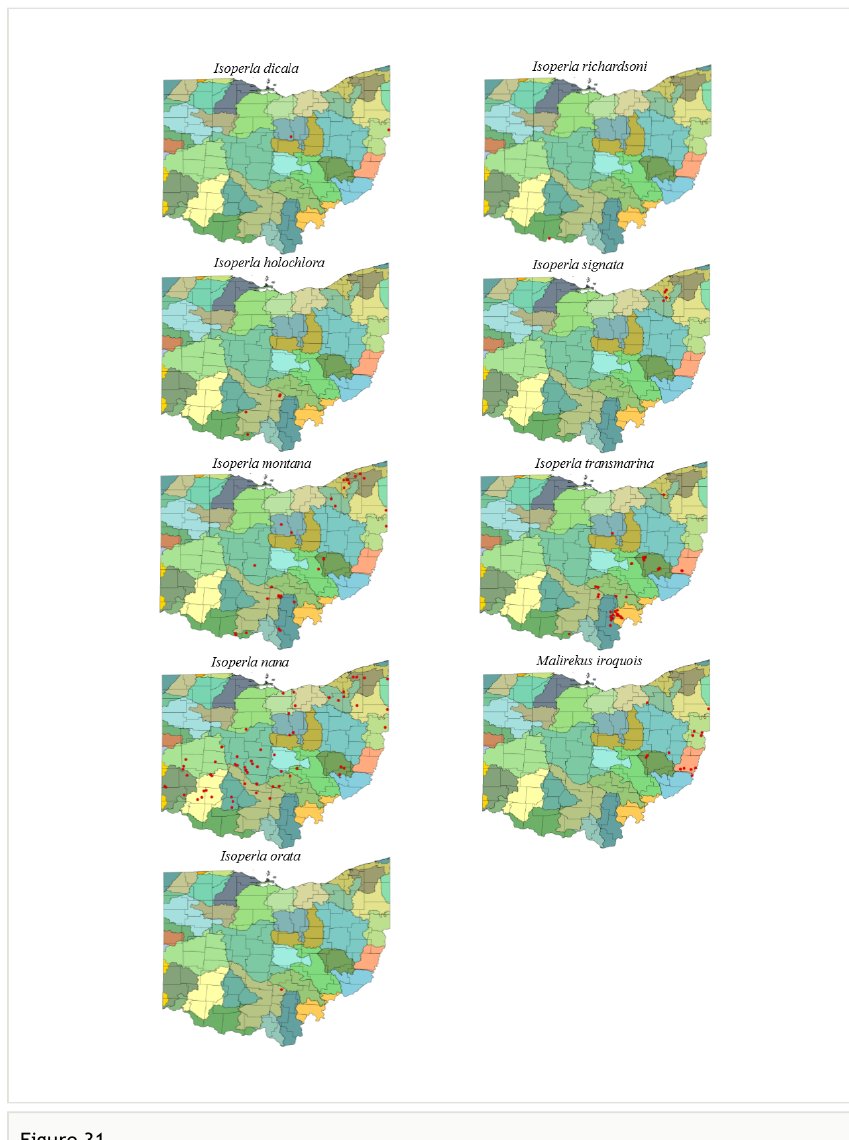
Figure 31. Distribution of Perlodidae in